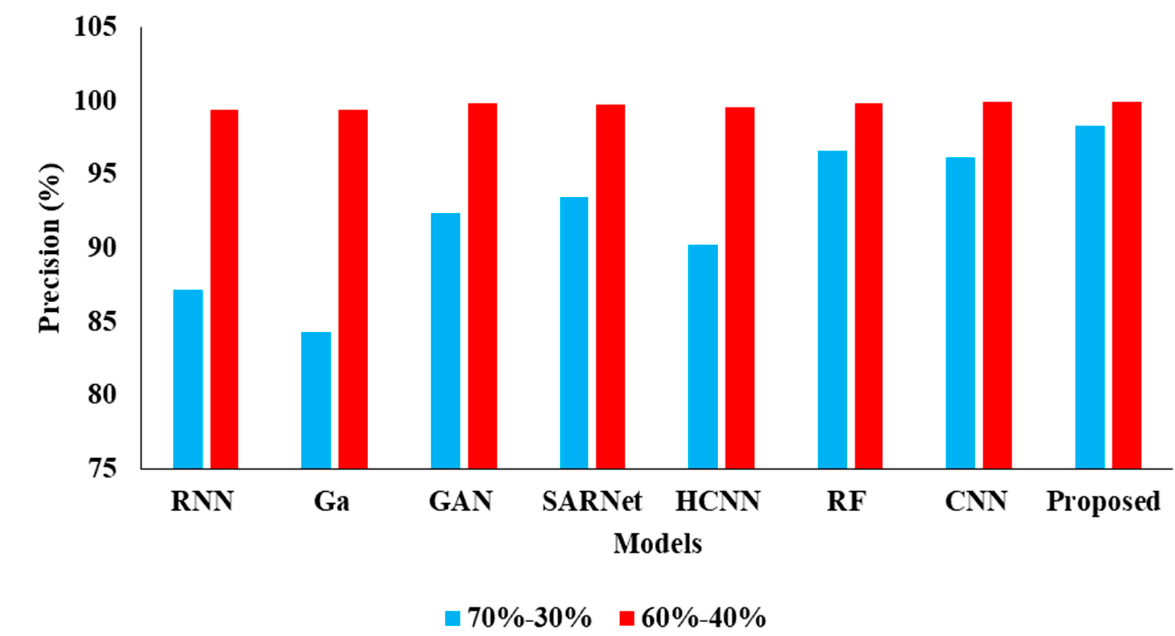
Figure 6. Precision Comparison for two data splits-ups.